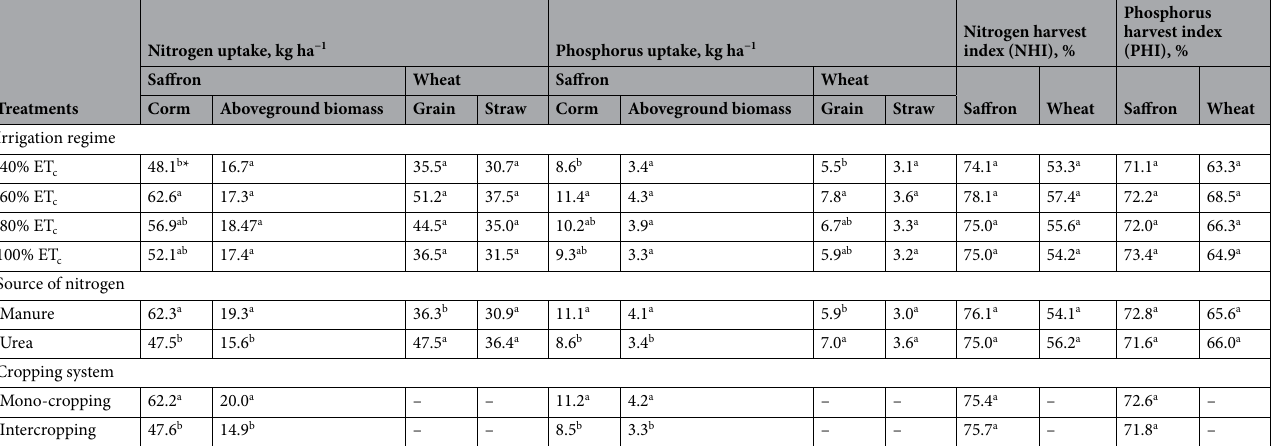
Table 8. Means for nutrient (nitrogen and phosphorus) uptake by saffron (corm and aboveground) and winter wheat (grain and straw) biomasses and nitrogen and phosphorus harvest indices for saffron and wheat, all for the last (fourth) growing season. *Means followed by similar letters in each column for each factor and each trait are not significantly different at 5% level of probability according to Tukey test.